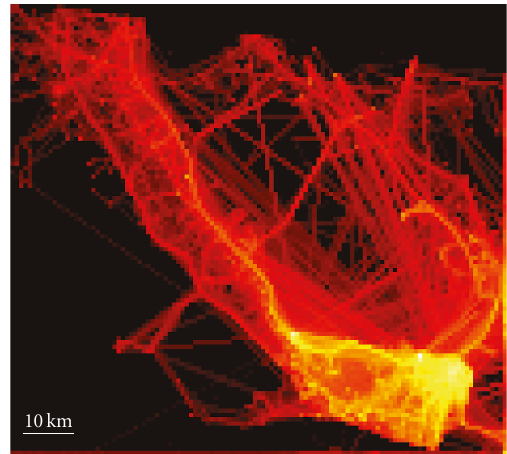
Figure 3: Superposition of the mobility patterns of all San Francisco taxicabs: intensity of color is proportional to the time globally spent on each